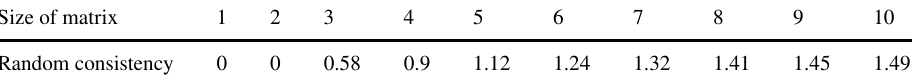
consistency (RI) for various matrix